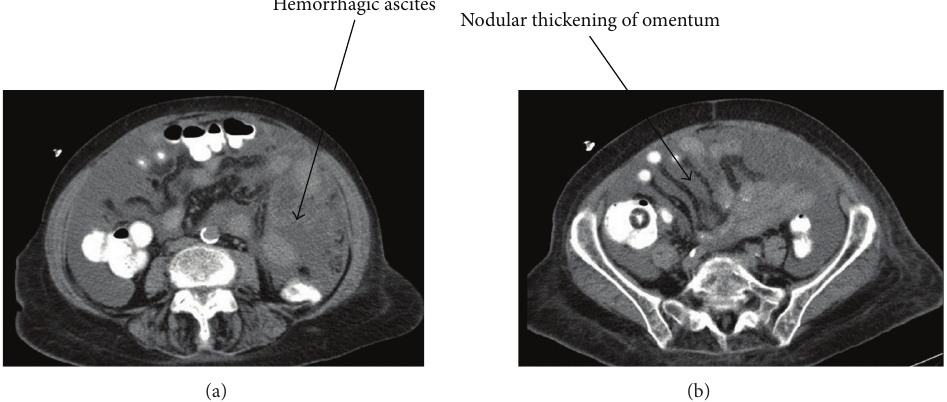
Figure 1: (a) Axial CAT scan images of extensive hemorrhagic ascites and (b) nodular thickening of the omentum and peritoneal surfaces.